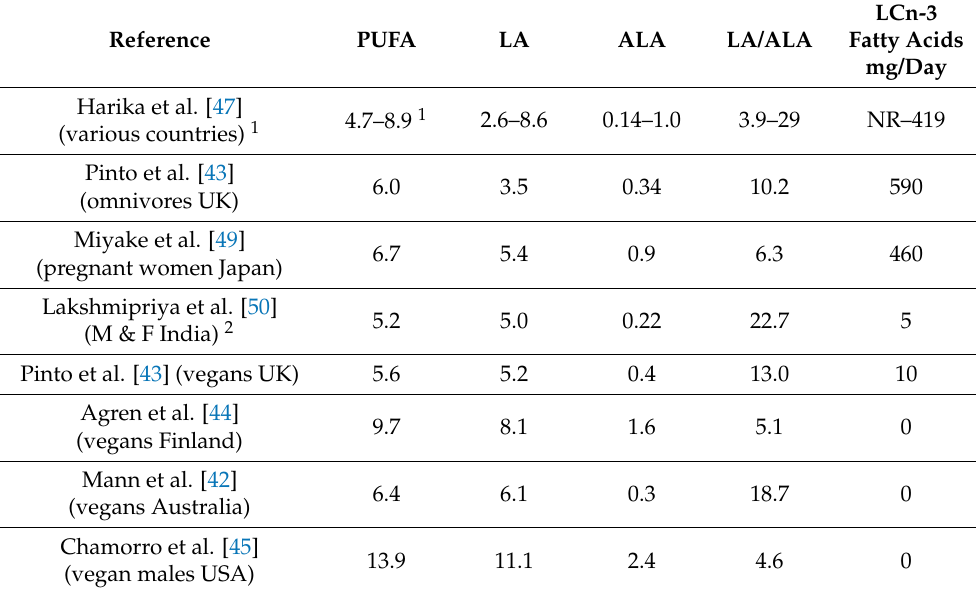
Table 2. Dietary intakes of PUFA, LA, ALA and LC n-3 fatty acids (data expressed as % energy for total PUFA, LA and